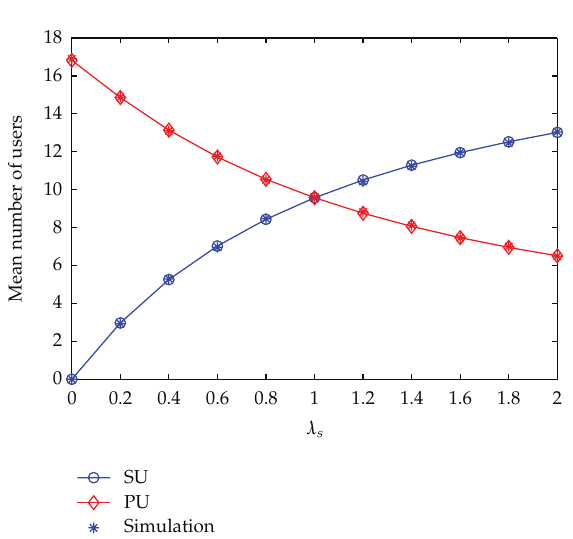
Figure 4: Expected number of users in SUE mode versus λ s . The system parameters are N (cid:8) 20, μ p (cid:8) μ s and λ p (cid:8) 1.